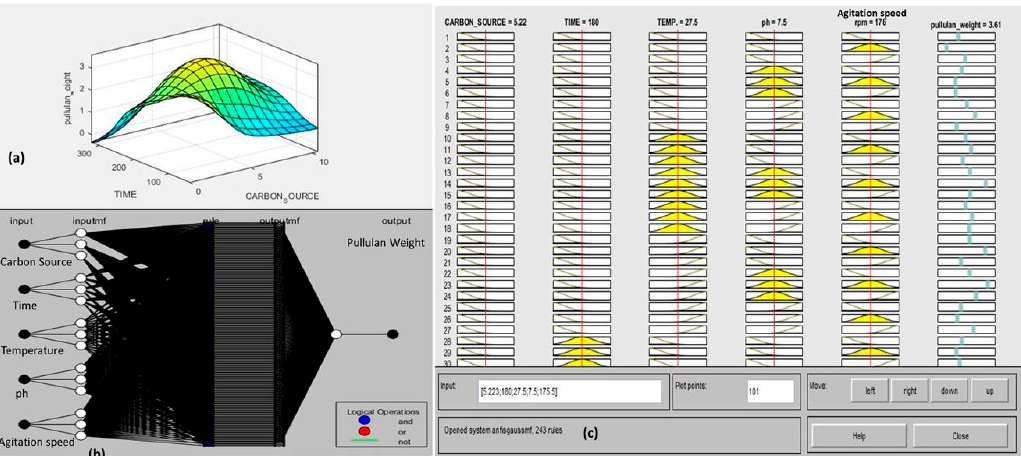
Figure 3. Training and optimization plots by the ANFIS tool for the optimization of pullulan yield. ( a ) ANFIS response surface figure. ( b ) ANFIS model structure for ‘trimf’. ( c ) Training routine of process variable (input) by ANFIS training rules.